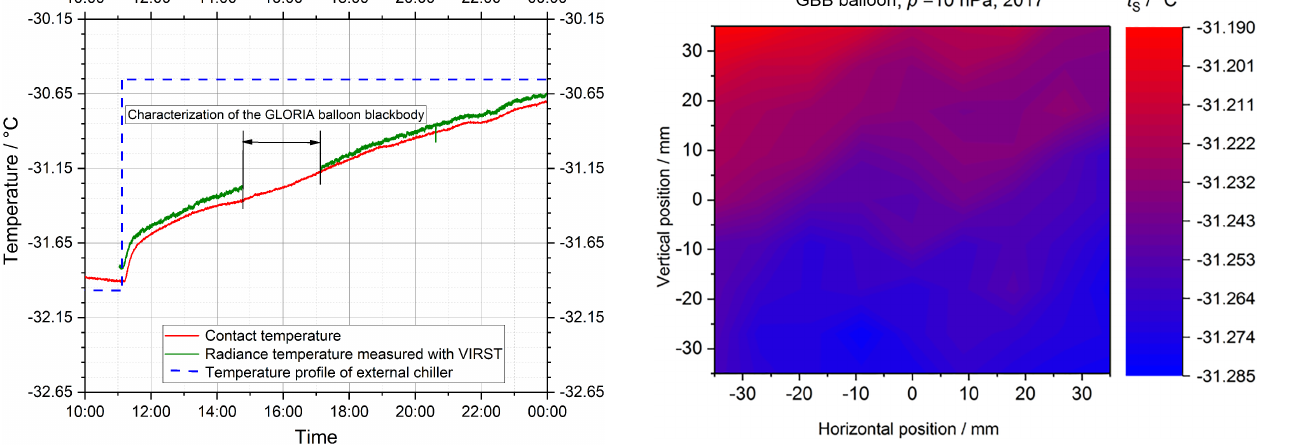
Figure 6. Change of radiance temperature and of contact tempera- ture in the backplane of the GLORIA balloon blackbody over time during phase change in PCM cooling pads.